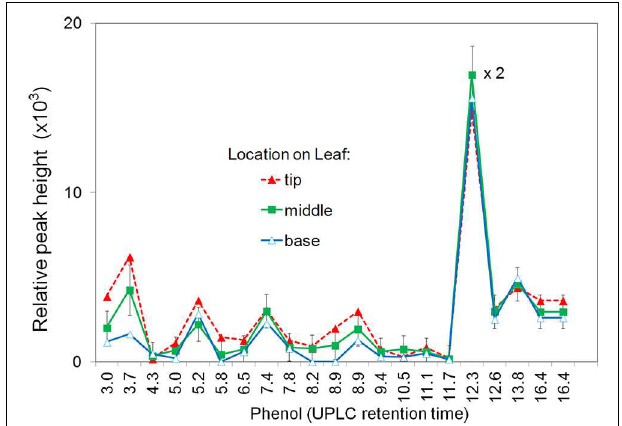
FIGURE 1 | Effect of segment location within the leaf on production of apoplastic phenolics in response to P. fluorescens . Leaf segments located at the tip, middle, or base of the leaf were infiltrated with 10 8 CFU ml − 1 P. fluorescens . After 6h the segments were analyzed for phenolic content using UPLC/UV/MS. The major phenolics are identified by retention time. See Materials and Methods for further